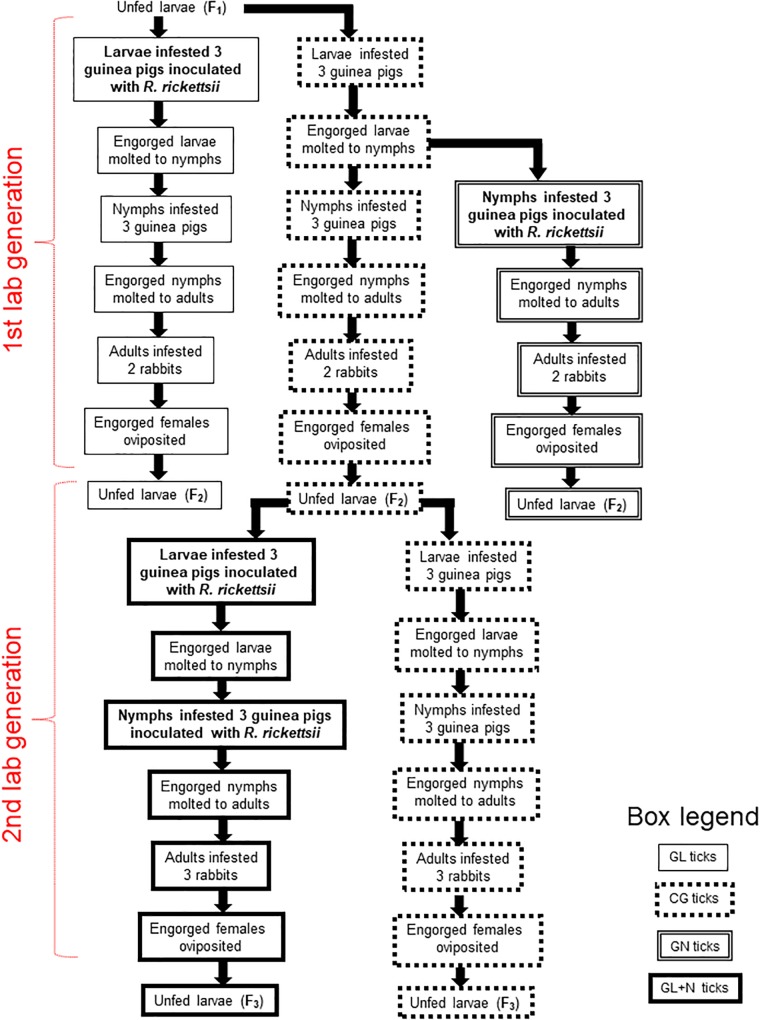
Diagram illustrating experimental procedures with each of the six colonies of Amblyomma sculptum ticks from F1 larvae to F3 larvae. GL and GN ticks were exposed to Rickettsia rickettsii-inoculated guinea pigs during the F1 larval and nymphal stages, respectively, and thereafter, they were reared through the F2 larval stage on susceptible animals (guinea pigs for larvae and nymphs; rabbits for adult ticks). GL + N ticks were dually exposed to R. rickettsii-inoculated guinea pigs, firstly during the F2 larval stage, secondly during the F2 nymphal stage, and then reared through the F3 larval stage on susceptible rabbits. CG ticks were the uninfected control group, always exposed to susceptible guinea pigs or rabbits in parallel to the infected groups.